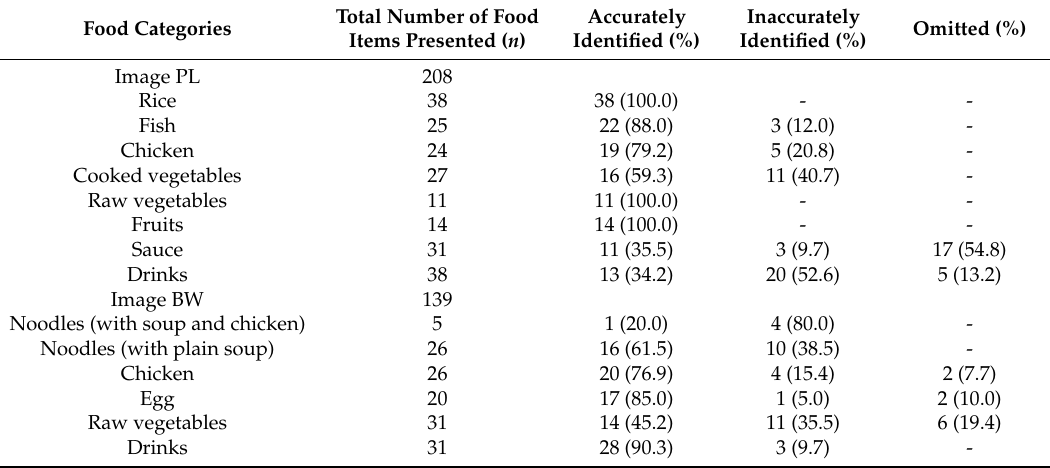
Table 3. Accuracy of food item identification based on food categories in Image PL ( n = 38) and Image BW ( n = 31).